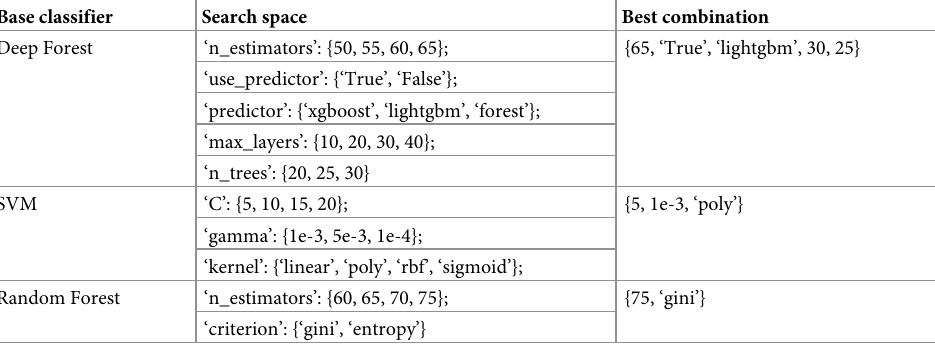
Table 2. Best combination of hyperparameters for each